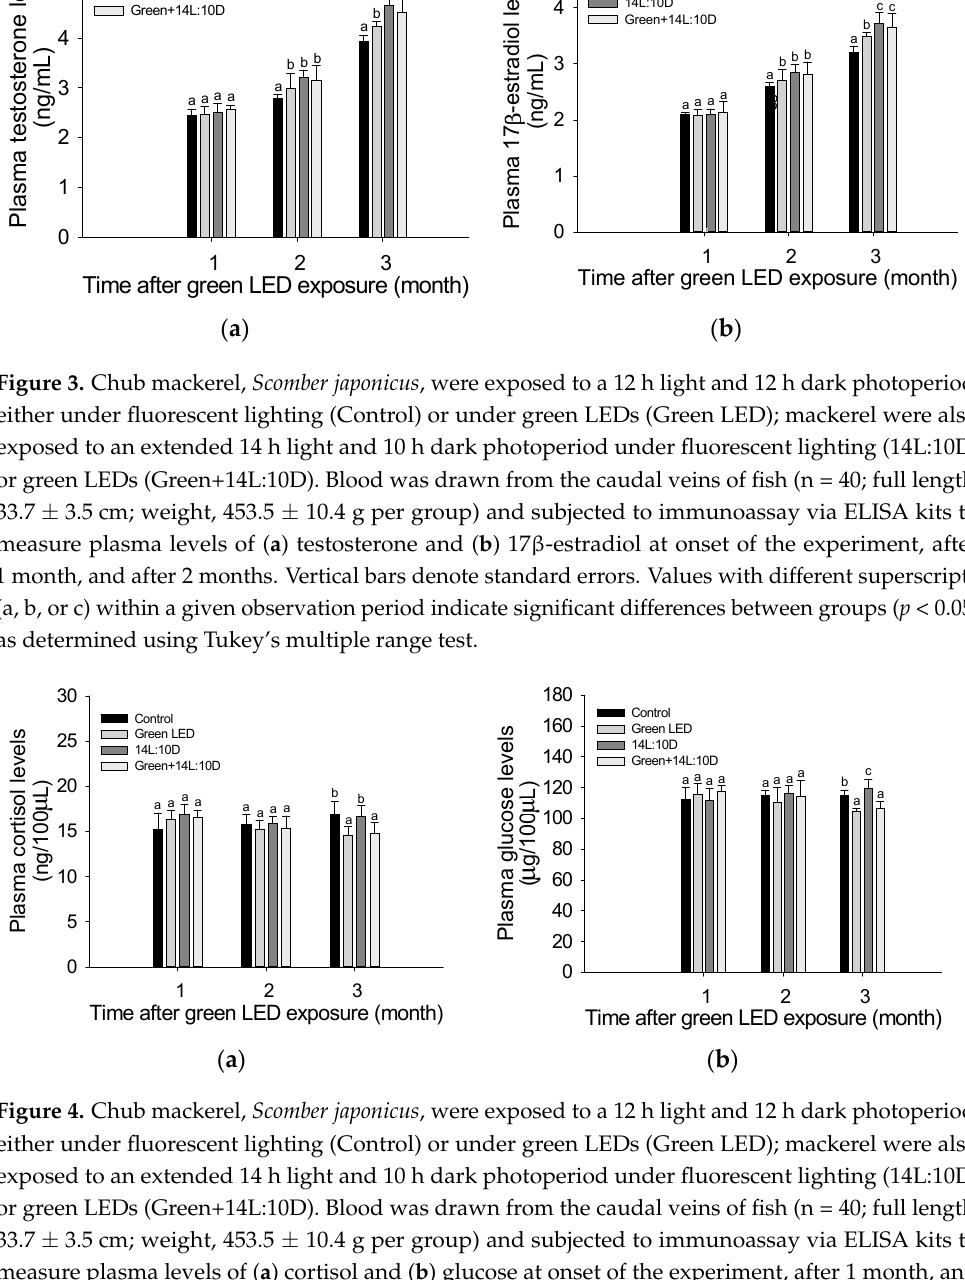
1 Time after green LED exposure (month)